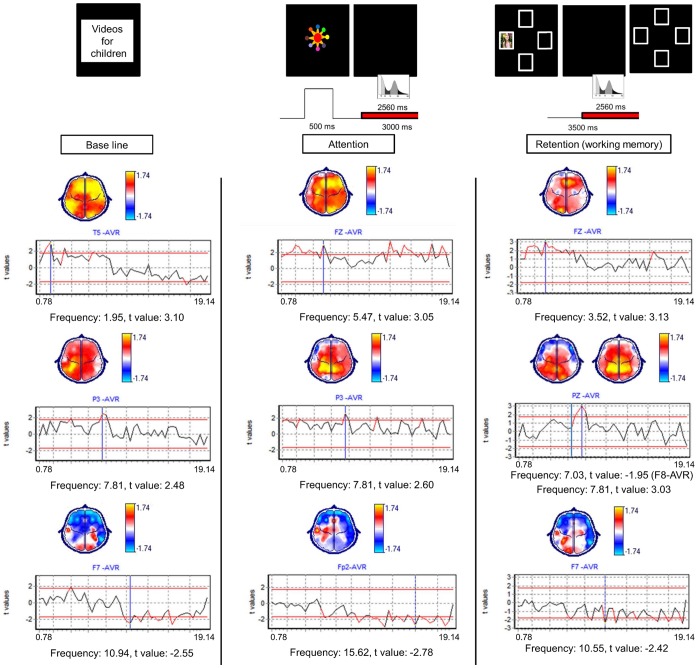
Post-hoc t-test comparing differences between groups in each of the conditions.On the Y-axis, t values are shown. Positive t values, shown in yellow on the topographic map, imply higher power in the PVL group compared to the healthy group. Negative t values, shown in blue on the topographic map, imply lower power in the PVL group compared to the healthy group.